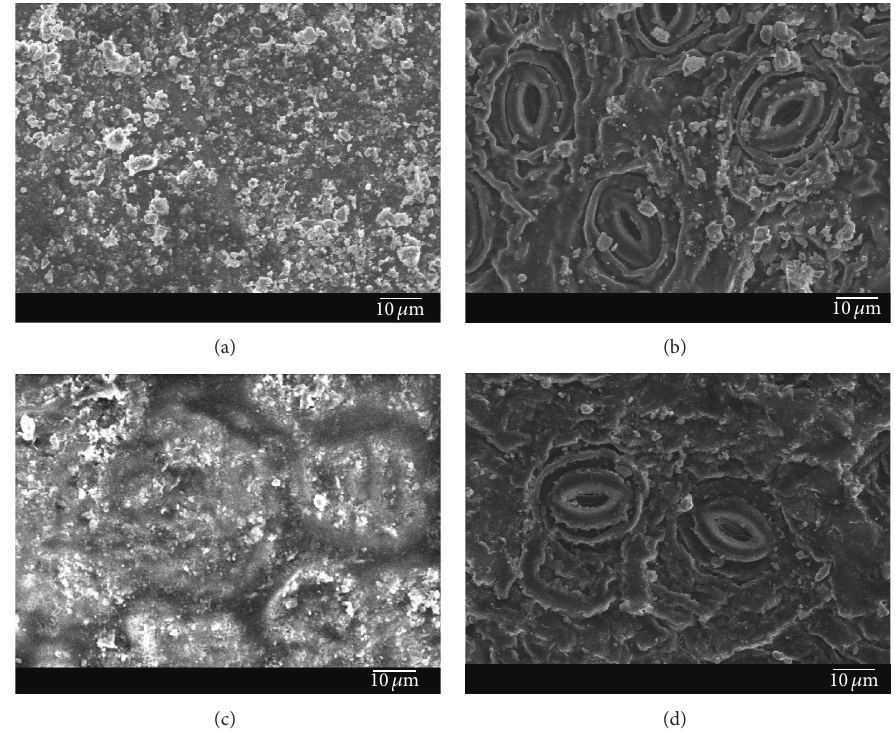
Figure 6: The upper ((a), (c)) and lower ((b), (d)) surfaces of leaves of L. lucidum before ((a), (b)) and after ((c), (d)) a rainfall